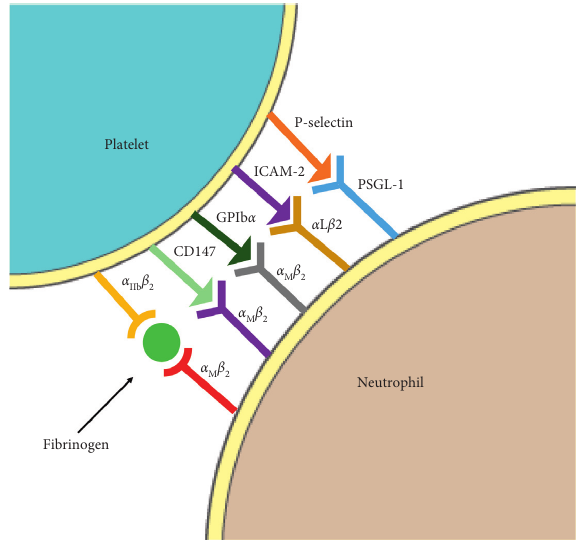
Figure 1: Overview of the most important platelets selectins and integrins related to platelets and neutrophils adhesion in MI. PSGL- 1 receptor binding is the first interaction between platelets and neutrophils. This interaction is stabilized by secondary adhesion interactions including directly binding GPIb α and indirectly binding α IIb β 3 of platelets with α M β 2 of neutrophils. The im- portance of interactions of ICAM-2 with α L β 2 and CD147 with α M β 2 in platelet-neutrophil adhesion is still poorly understood. PSGL1: P-selectin glycoprotein ligand-1; ICAM2: intercellular adhesion molecule; MI: myocardial infarction. The server https:// smart.servier.com was used to create a